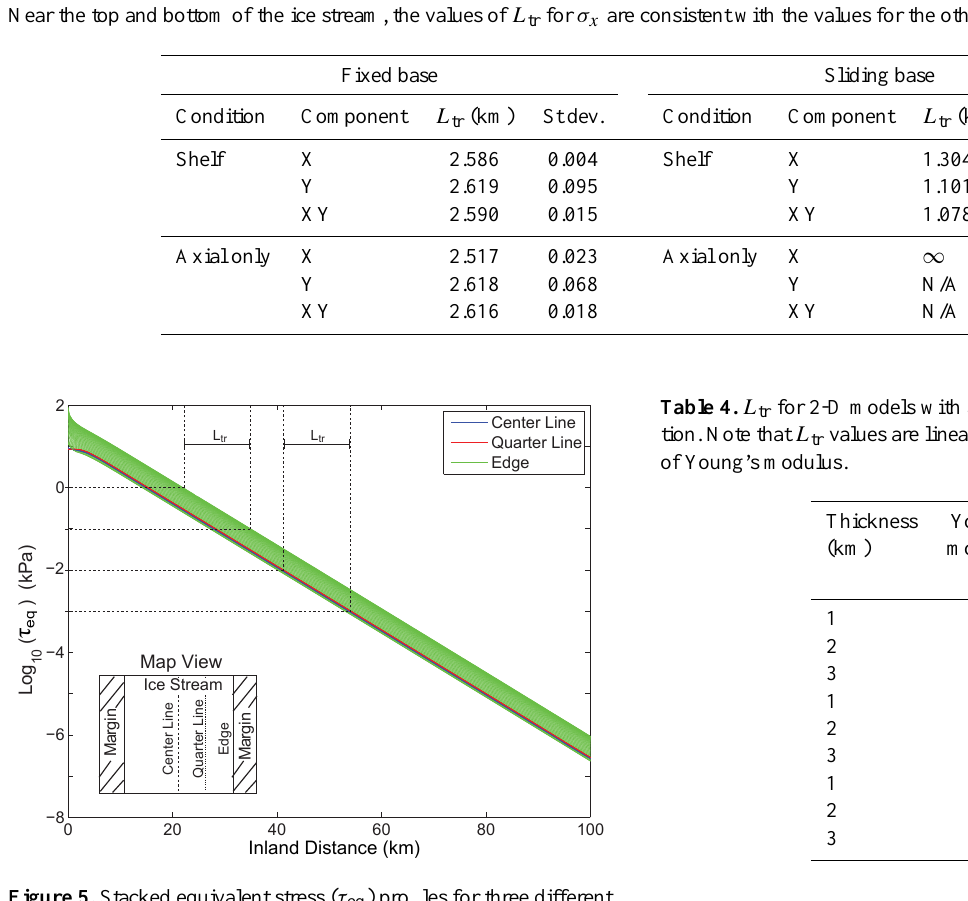
Figure 5. Stacked equivalent stress ( τ eq ) profiles for three different locations in a 3-D homogeneous elastic model 10km wide and a 1km thick. Inset shows locations of the three profiles in map view. For each location, 101 lines are stacked, taken at 10m depth in- tervals. For the center and quarter lines, there is little difference in stress with depth, while for the edge of the ice stream, the stress changes with depth by about an order of magnitude. However, L tr is the same independent of lateral position (center, quarter, or edge).